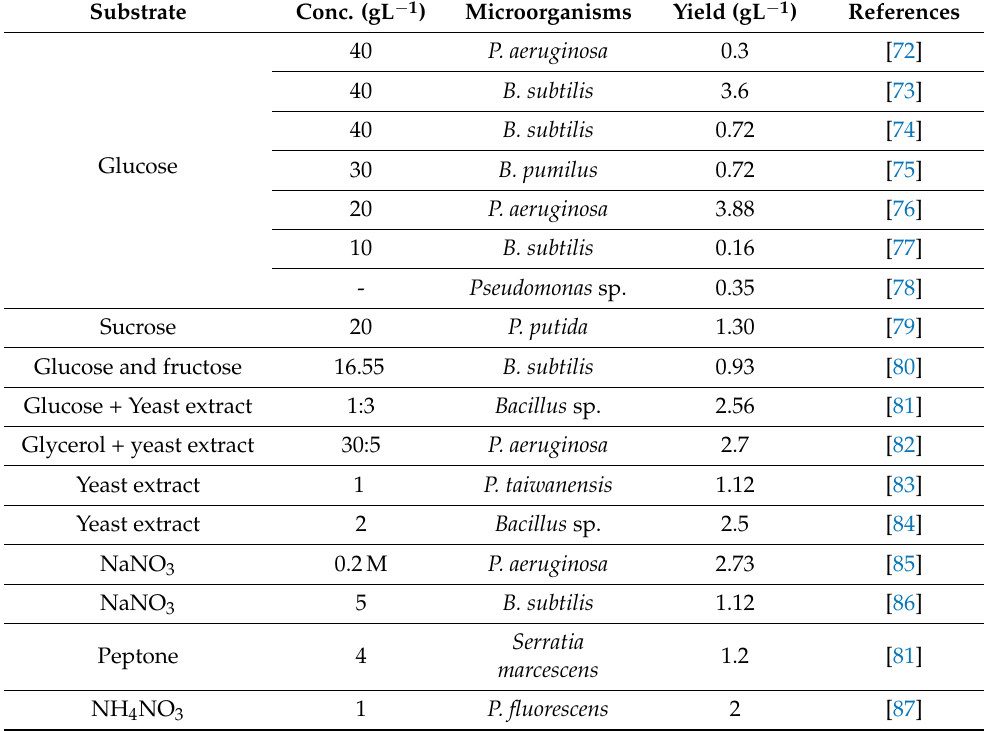
Table 3. The common substrates used in biosurfactant production and their yields. Substrate Conc. (gL − 1